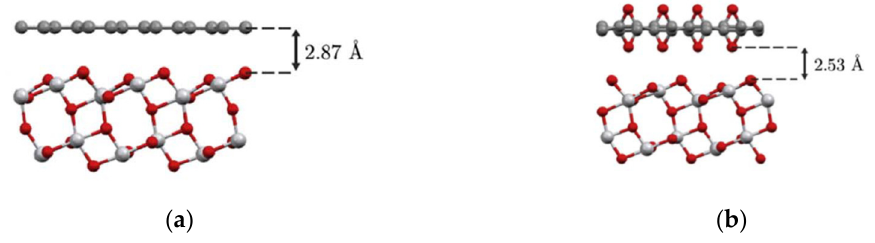
Figure 9. Interaction with the (101) surface of anatase of graphene ( a ) and graphene oxide ( b ). Reproduced with permission from Reference [95]; copyright (2018) Elsevier.